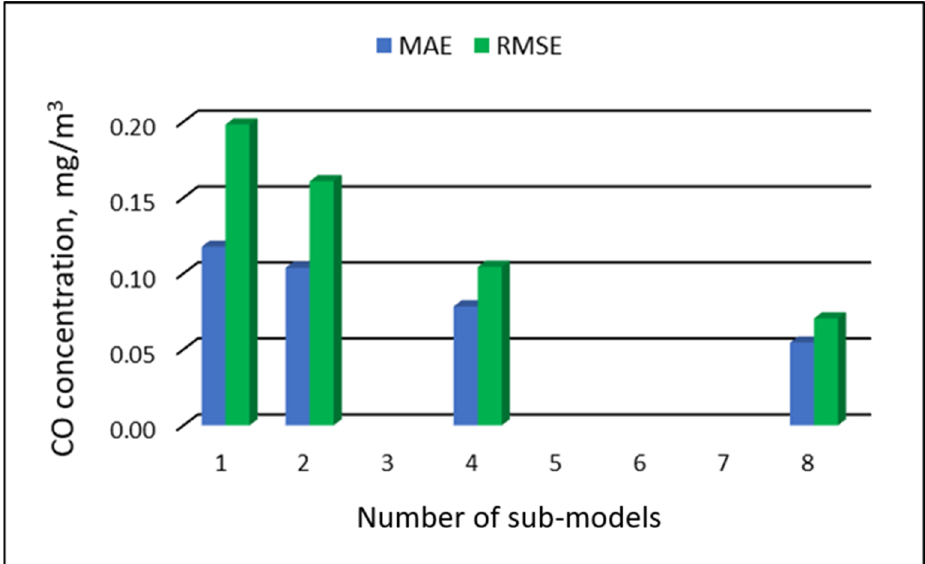
Figure 26. Overall MAE and RMSE values for CO concentration prediction in RVS models depending on the number of created sub-models,